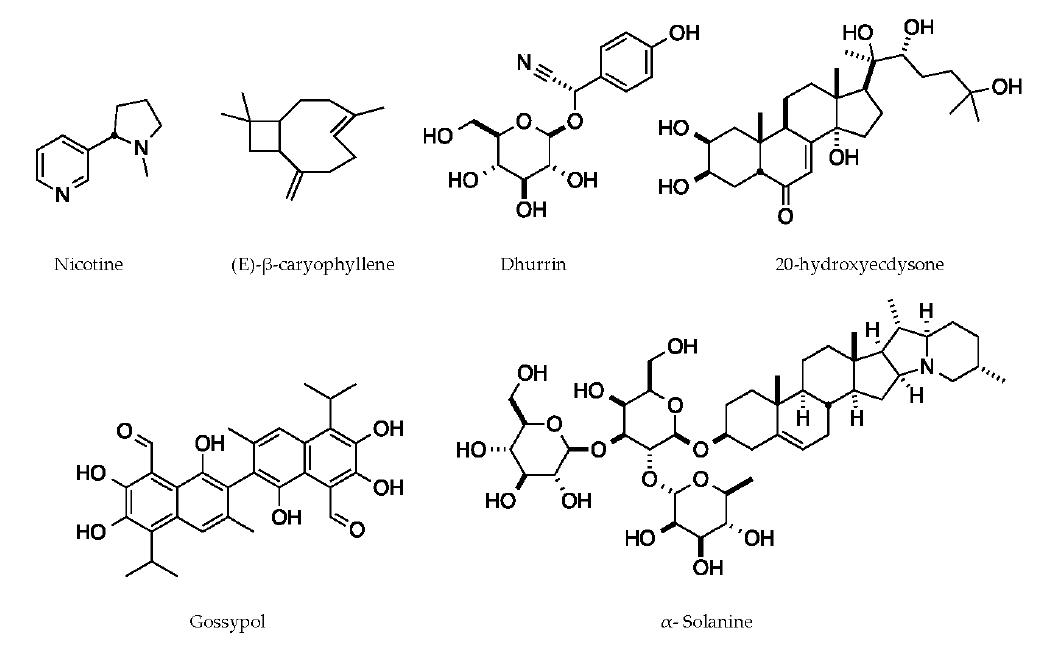
Figure 2. Representative chemical structures of plant defense compounds with known functions.